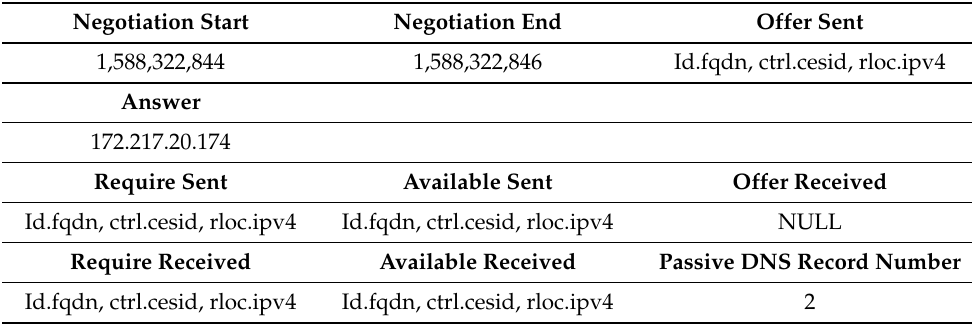
Table 5. Exemplary output of the Passive DNS with CETP support–Policies.